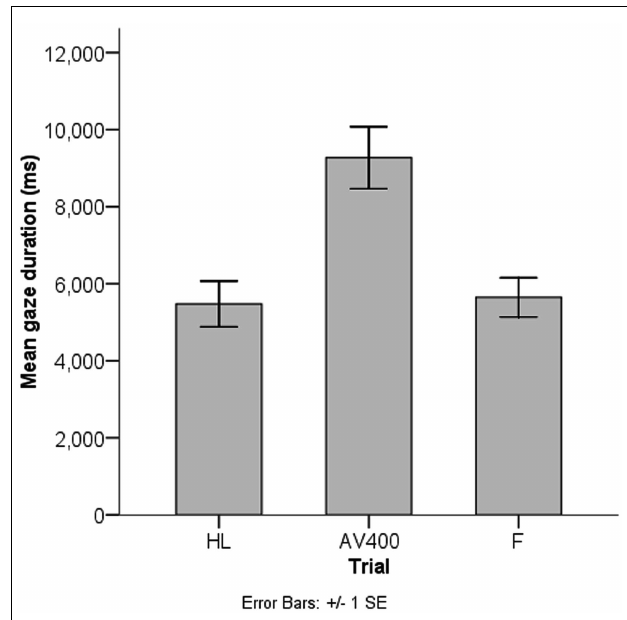
FIGURE 3 | Results of the behavioral habituation paradigm. Infants ( n = 45) looked to the asynchronous test stimulus (AV400) for longer on average than to the familiar synchronous stimulus as shown for the last habituation trial (HL) and the familiar test trial (F).